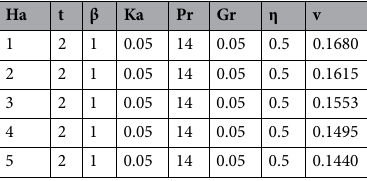
Table 3. Finite difference scheme results of velocity for different values of Ha.